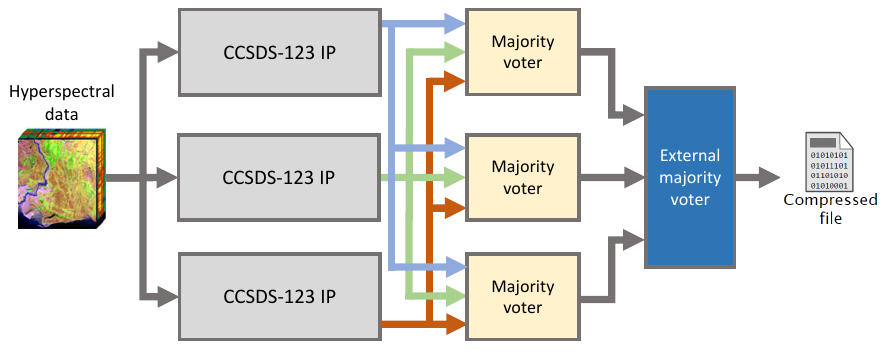
Figure 8. Triple Modular Redundancy (TMR) protection